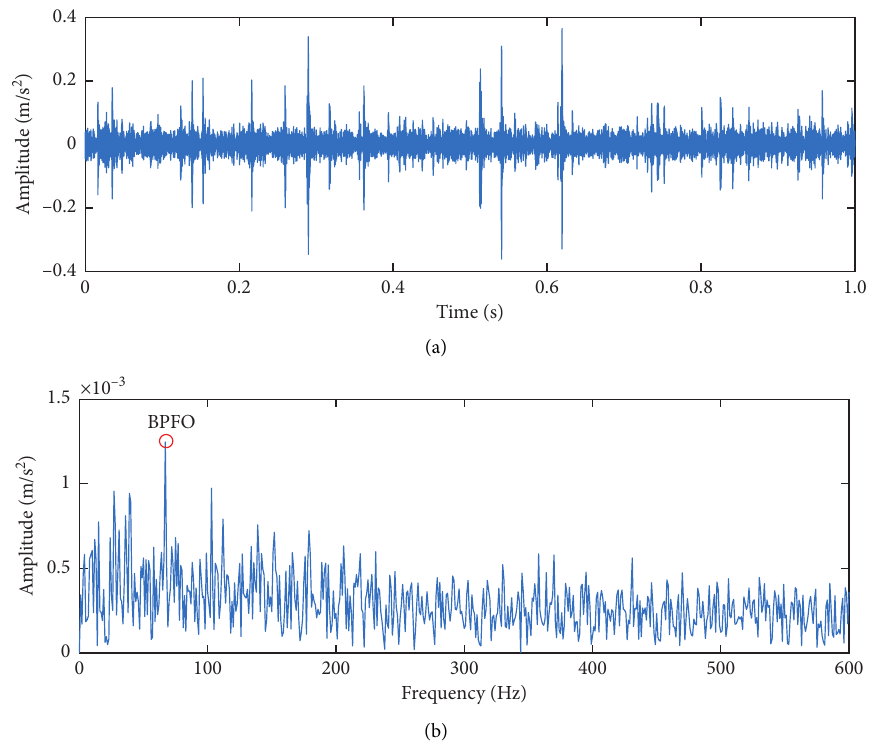
Figure 29: Experimental signals of case 2: (a) the time-domain waveform of u3 and (b) the squared envelope